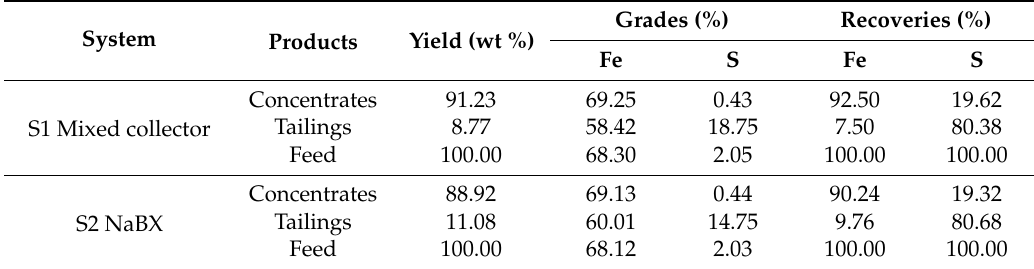
Table 5. The results of industrial flotation tests on September.